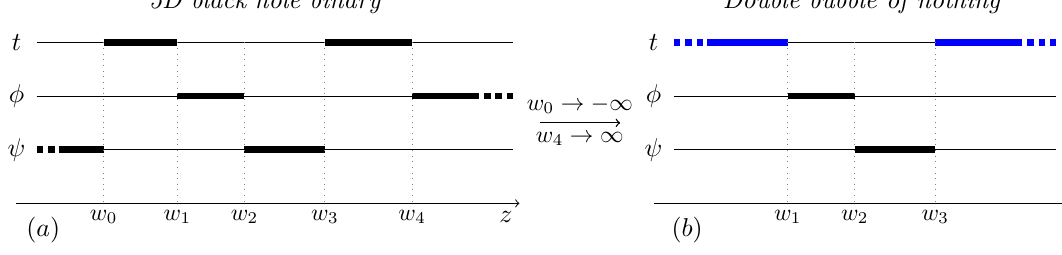
z = w 2 ). In the maximal analytic